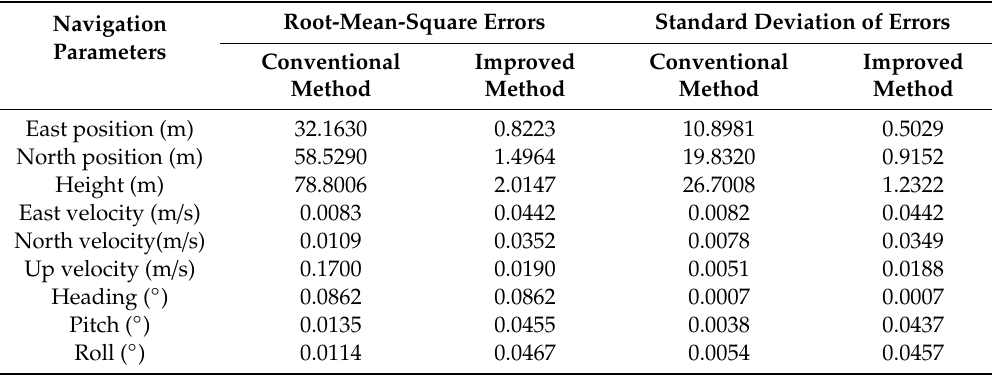
Table 2. Numerical statistics and camparison of linearization methods (after 200 s).